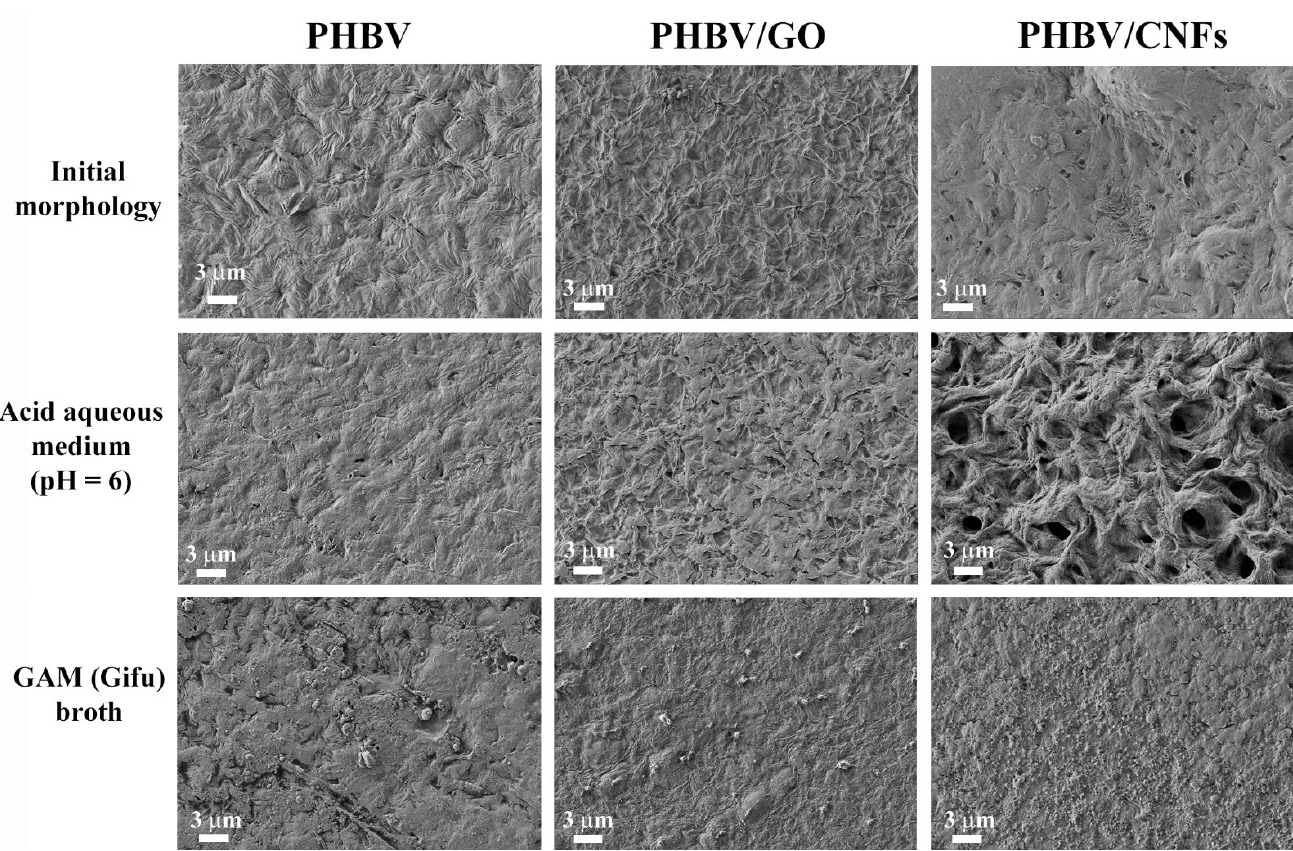
Figure 4. HRFESEM surface images of PHBV, PHBV/GO and PHBV/CNFs before (initial morphol- ogy) and after degradation in acid aqueous medium (pH = 6) and GAM (Gifu) broth for 3 months.